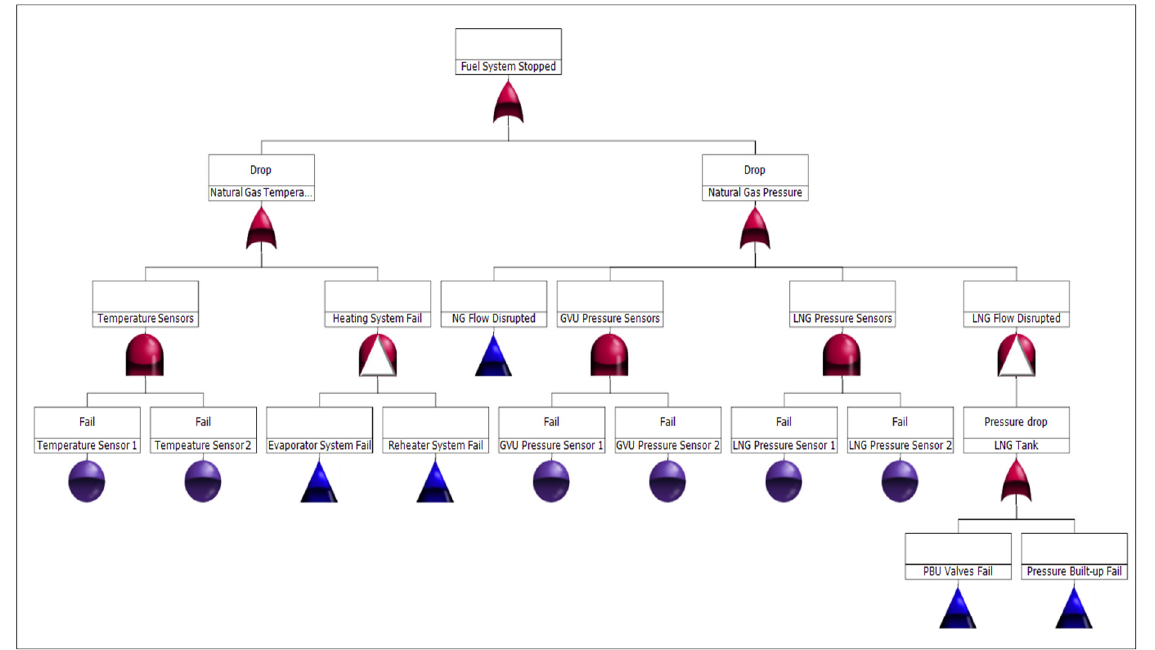
Figure 10. Modified LNG fuel system configuration Fault Tree developed in PTC Windchill.